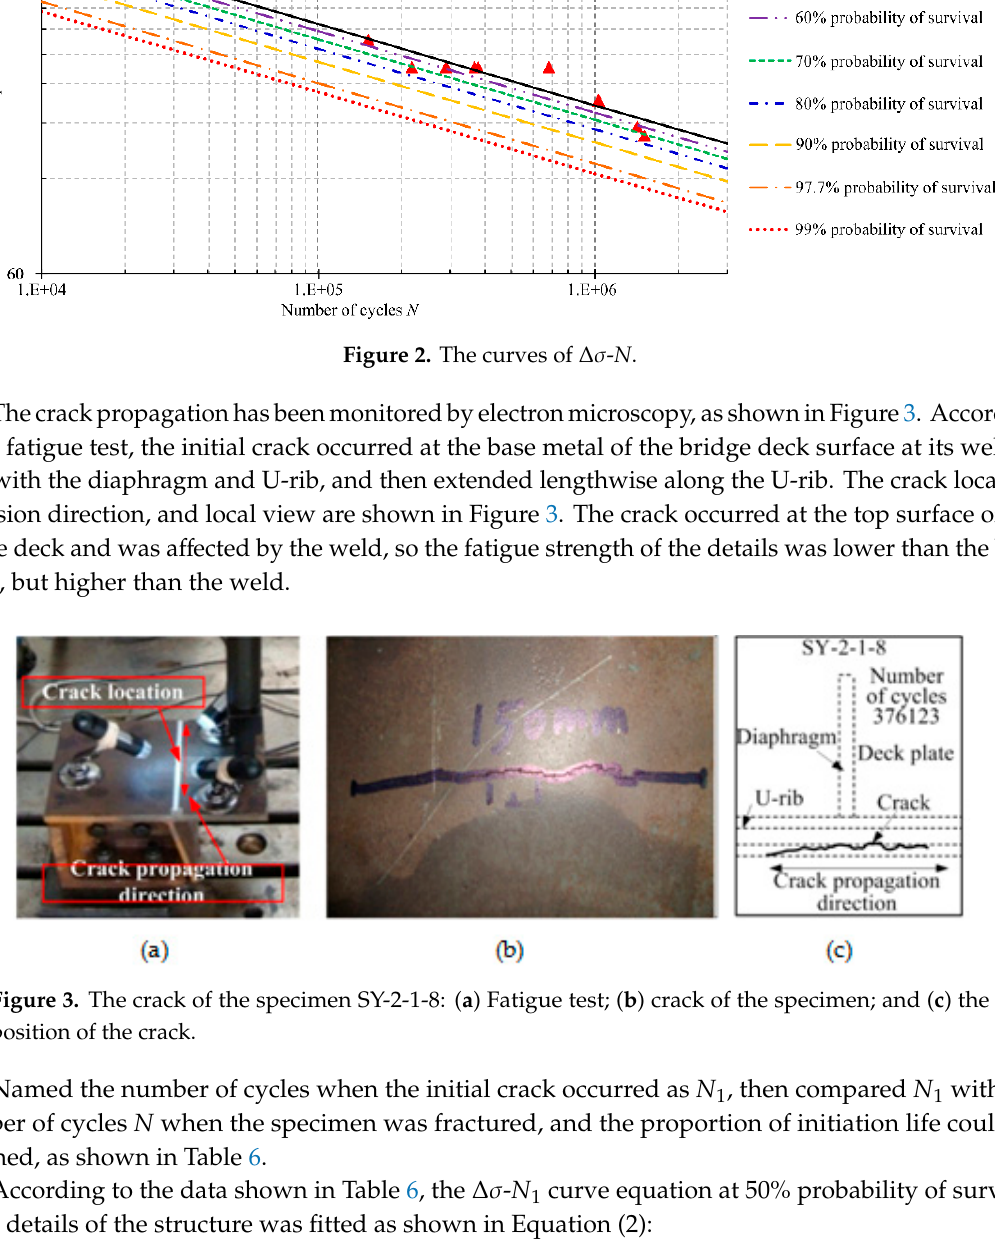
Table 6. The proportion of initiation life for each specimen.